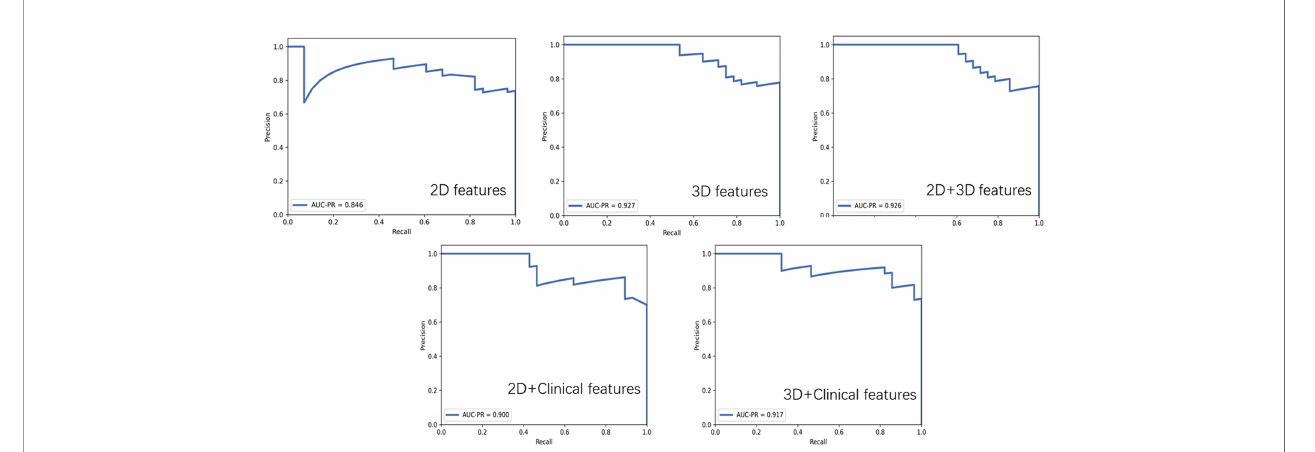
FIGURE 6 | The precision-recall plots of optimal models based on